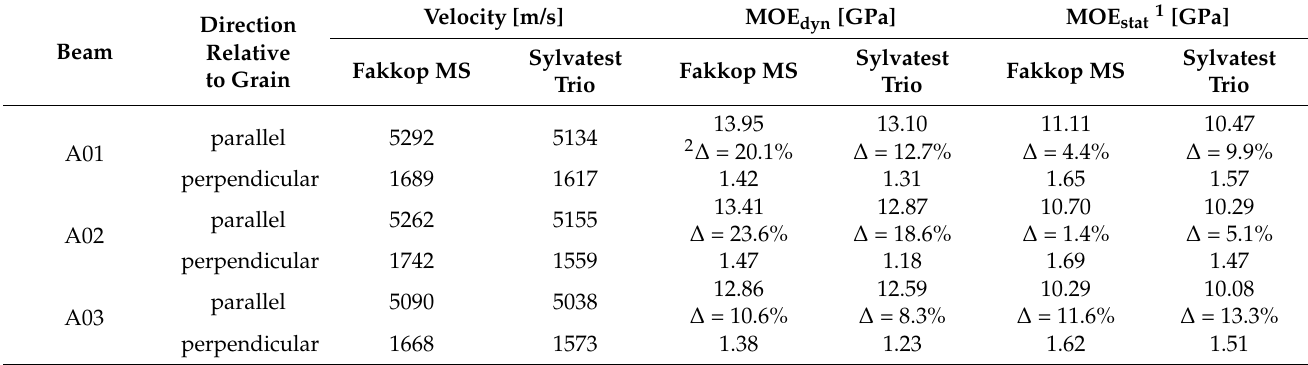
Table 7. The results of the acoustic tests with Fakopp MS and Sylvatest Trio- mean